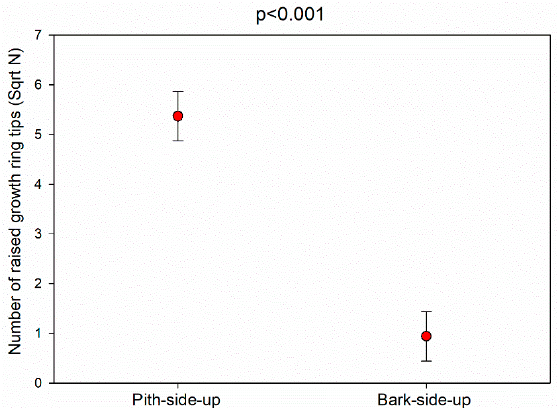
Figure 9. Effects of growth ring orientation on the numbers of latewood tips that projected above the surface of profiled western larch deckboards exposed to natural weathering for seven months in Vancouver, Canada. The results are averaged across boards with different profiles because there was no significant ( p > 0.05) interaction of growth ring orientation and profile type on numbers of raised latewood tips. Error bars = Least significant difference, p < 0.05.